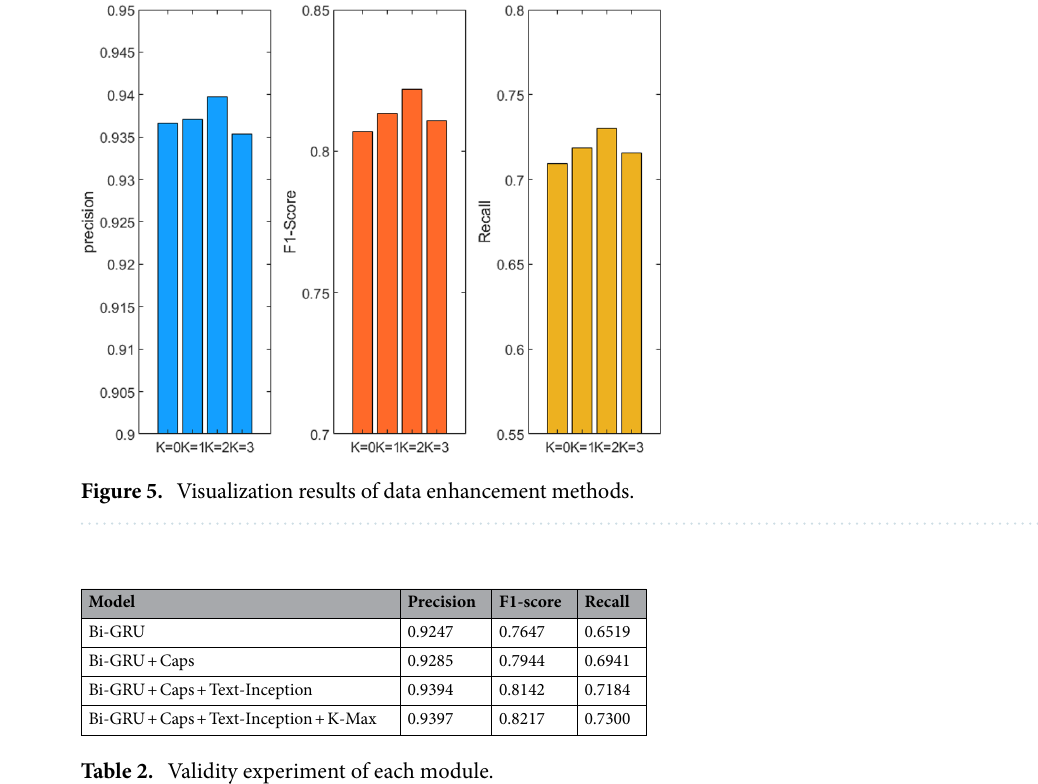
Table 2. Validity experiment of each